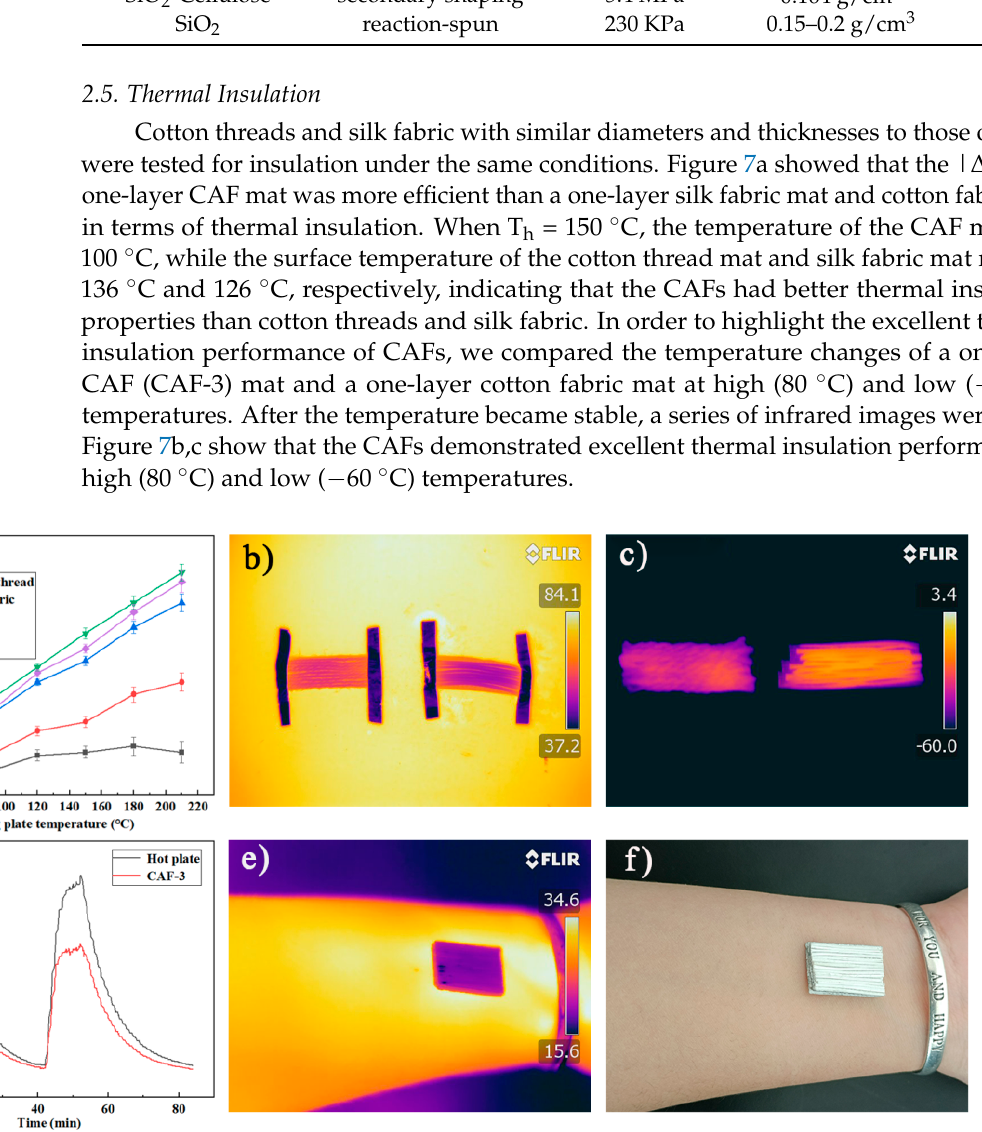
Figure 7. Thermal insulation properties of CAFs, silk fabric, and cotton threads. Temperature difference between the fiber surface and hot plate versus temperature of the hot plate for the single-layer mats made of CAFs, silk fabric, and cotton threads ( a ). Infrared images of one-layer mats of CAF-3 and cotton threads at high and low temperatures ( b , c ). Temperature-time curves of CAF-3 and hot plate ( d ). Infrared images and optical images of the CAF-3 fabric covered on a human arm for the room-temperature thermal insulation test ( e , f ).